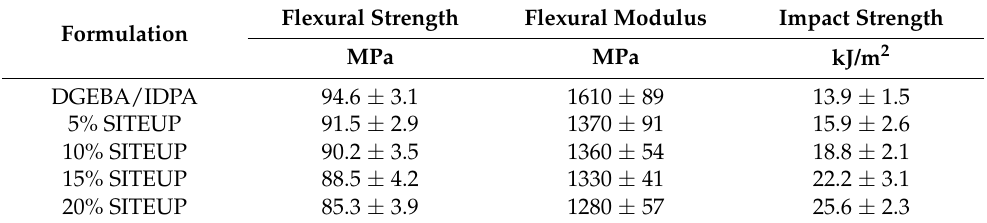
Table 1. Mechanical properties of cured epoxy thermosets modified with different contents of SITEUP. Flexural Strength Flexural Modulus Impact Strength Formulation MPa MPa kJ/m 2